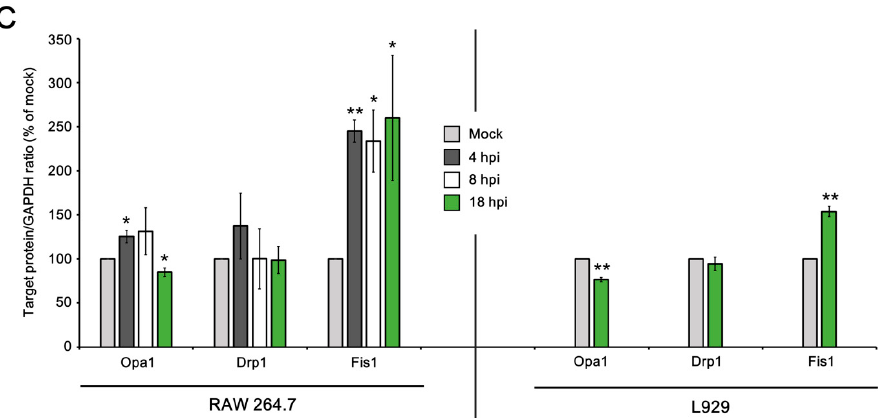
Figure 6. Level of mitochondrial fusion (optic atrophy protein 1, Opa1) and fission (dynamin-related protein 1, Drp1, and fission protein 1, Fis1) proteins in RAW 264.7 and L929 cells during ECTV infection. Representative Western blots of Opa1, Drp1, and Fis1 at 4, 8, 18 hpi in RAW 264.7 macrophages ( A ) and at 18 hpi in L929 fibroblasts ( B ). ( C ) Densitometry analysis of Opa1, Drp1, and Fis1 at 4, 8, 18 hpi in RAW 264.7 cells and at 18 hpi in L929 cells. The level of each protein was normalized to glyceraldehyde-3-phosphate dehydrogenase (GAPDH). Data from three independent experiments are presented as mean ± SD. Student’s t -test; * p ≤ 0.05; ** p ≤ 0.01.